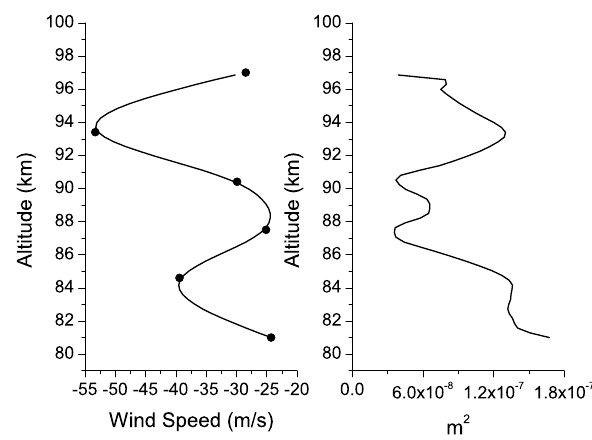
Fig. 18. Projected Esrange winds (left) and calculated m 2 (right) profiles for the 29/30 January event at 23:00 UT. The m 2 values are positive over the entire altitude range indicating a freely propagating wave.